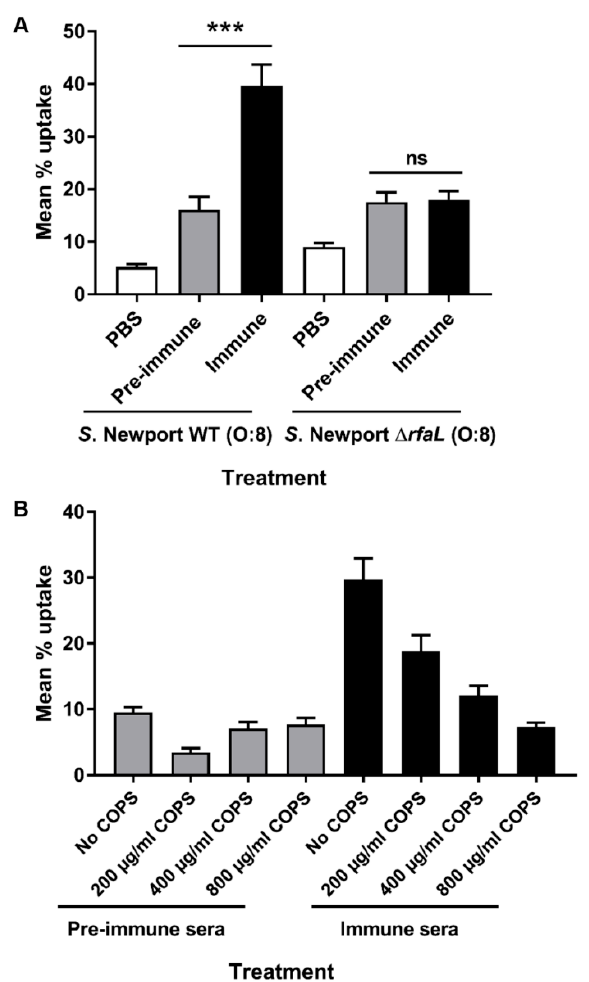
Figure 5. Contribution of anti-LPS antibodies to opsonophagocytic uptake by J774 macrophages. ( A ) S . Newport WT and ∆ rfaL mutant were treated with PBS, pre-immune or CVD 1979-immune sera and uptake by J774 cells was determined. *** p <0.001; ns, not significant (two-tailed Student’s t -test). ( B ) Serum from CVD 1979-immunized mice was pre-adsorbed with COPS prior to incubation with S . Newport WT and then added to J774 cells to determine uptake. Data shown is the mean uptake of three independent experiments and represented as mean ± SEM.